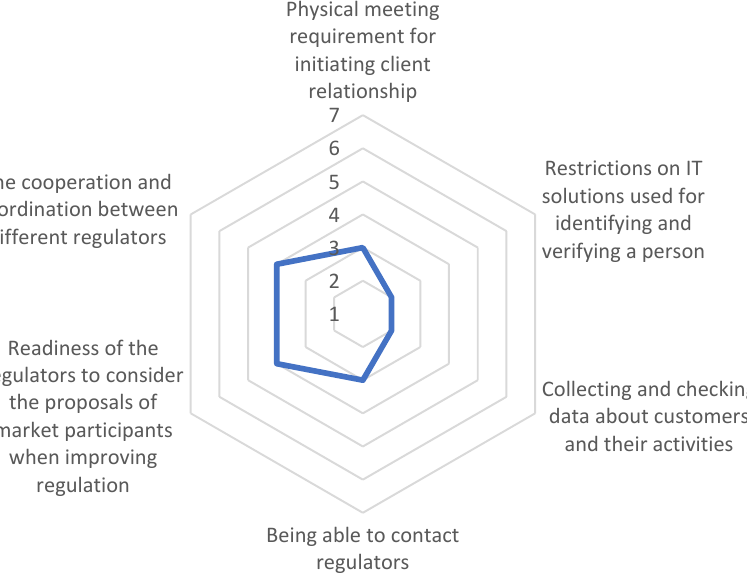
Figure 1. Regulative and regulator-related factors restricting the expansion into foreign markets on a scale from 1 (not pressing) to 7 (extremely pressing), medians.